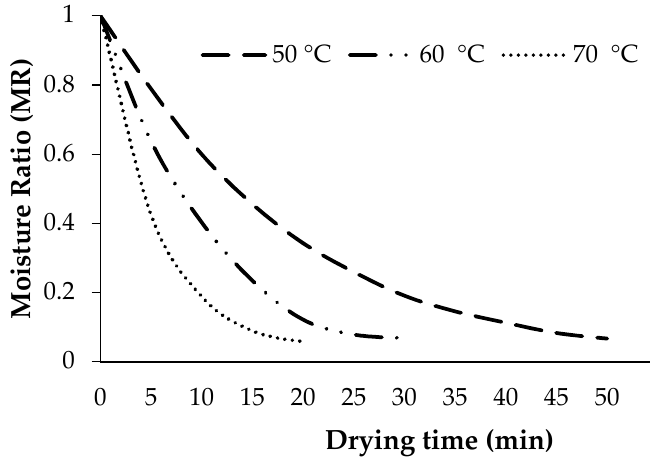
Figure 3. Drying characteristics of linden leaf samples.